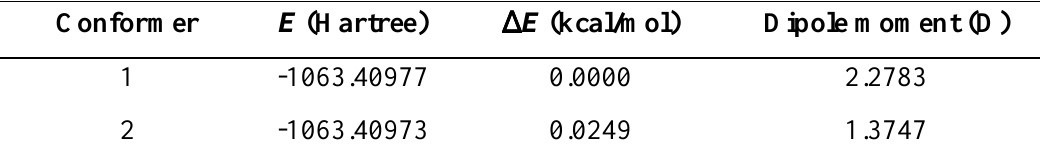
Table 1. Energies of the different conformations of the title compound calculated at the HF/6-311G(d,p) level a